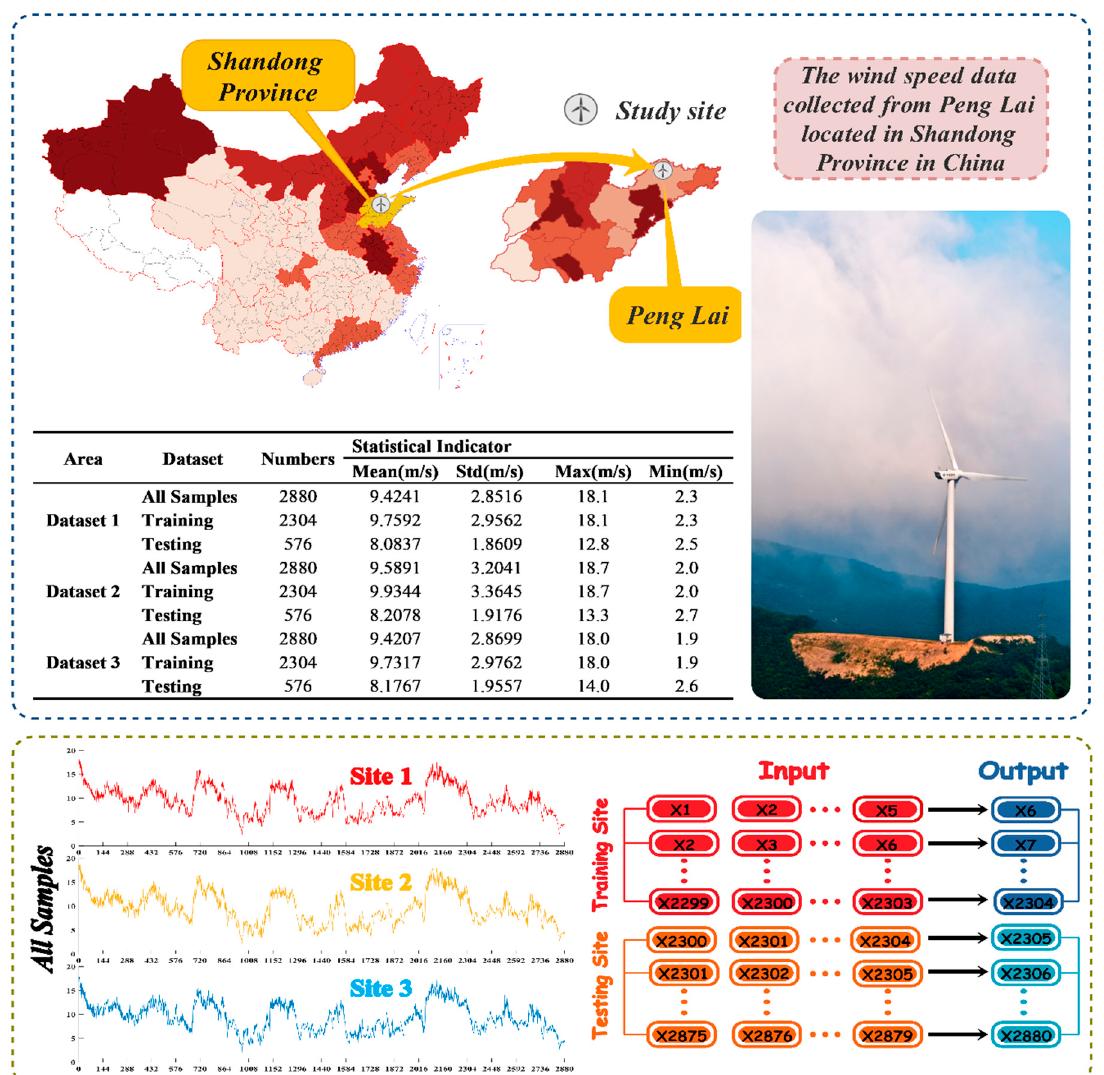
Figure 2. Observation sites of wind farms and data information.